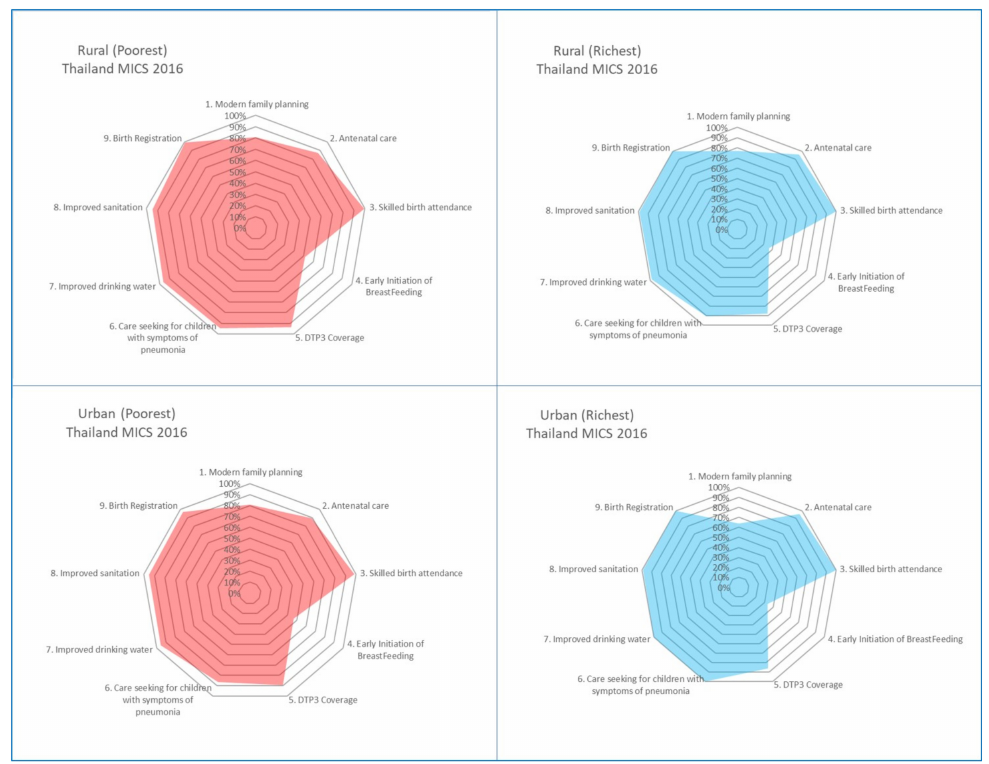
Figure 5. Synergies of vulnerability: urban / rural and rich-poor quintiles, Thailand. Data source: Thailand MICS 2016 [14].